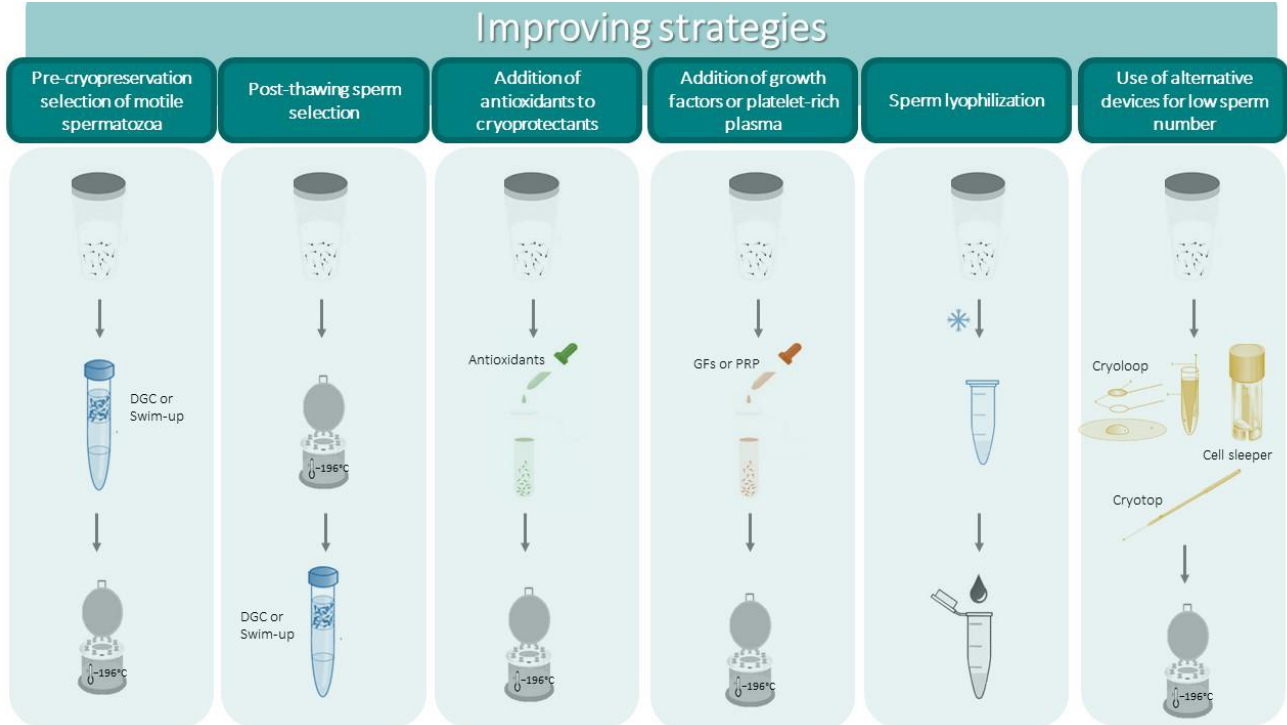
Figure 2. Schematic representation of strategies to improve the outcomes of cryopreservation and to cryopreserve low sperm numbers.